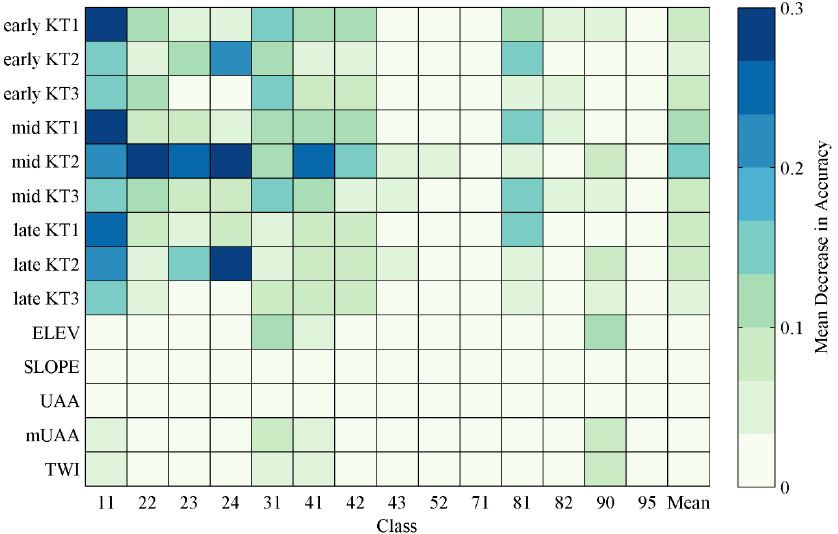
Figure 7. Mean decrease in agreement between NLCD and AASG2 when a given variable is excluded.